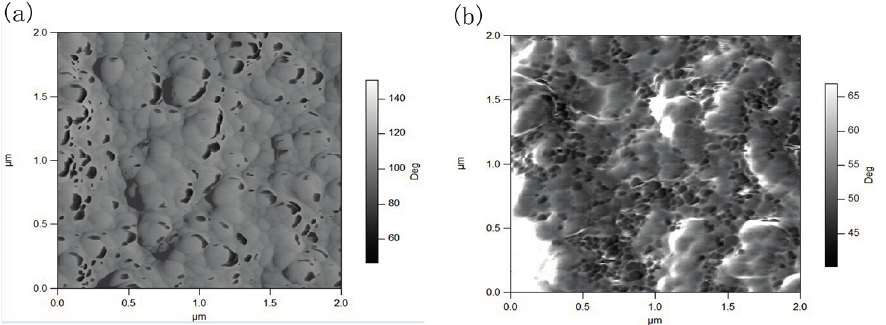
Figure 14. AFM amplitude images of P3HT-ZnO hybrid thin film stored after ( a ) 1 and ( b ) 15 days.